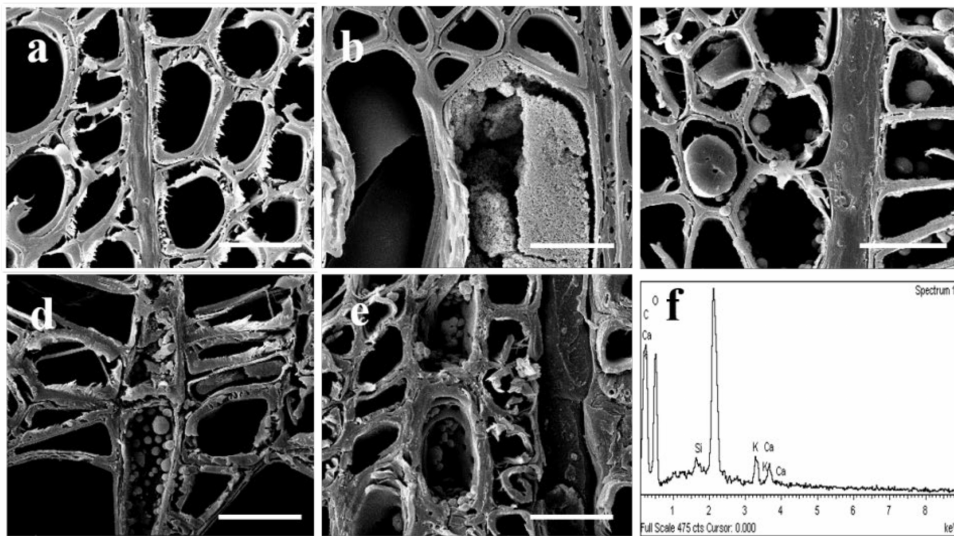
Figure 5. SEM images of the poplar cross section under different treatment conditions, ( a ) for the unmodified treatment group, ( b – d ) for the 110,100 mmol/L TEOS modification treatment group and ( e ) for the SiO 2 colloidal modification treatment group; ( f ) for vessel the EDS spectrum, bar 20 µ